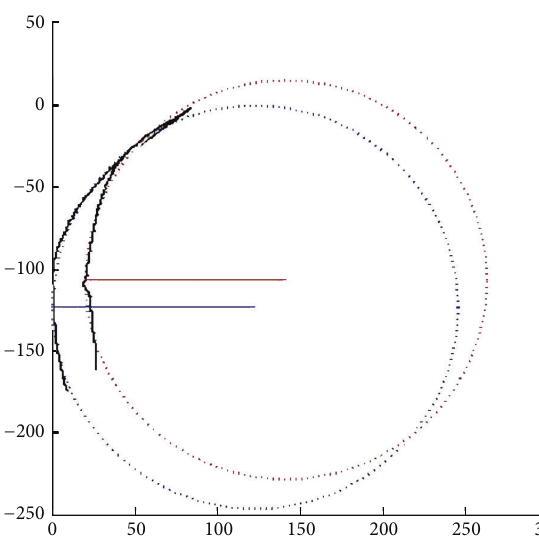
Figure 2: Method of curvature calculation. The curvatures of the extracted traces were calculated in Matlab (R2014 a, Mathworks). A circleinCartesiancoordinatewasfittoeachtracewithoutputsofthe center point and radius. The fitted circles were plotted and overlaid with the original traces. R (blue) = 123.0231; R (red) =